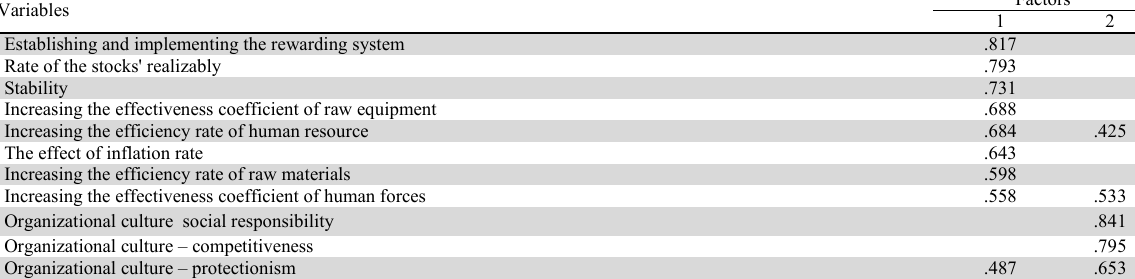
The results of PCA after Varimax rotation for privatization Variables